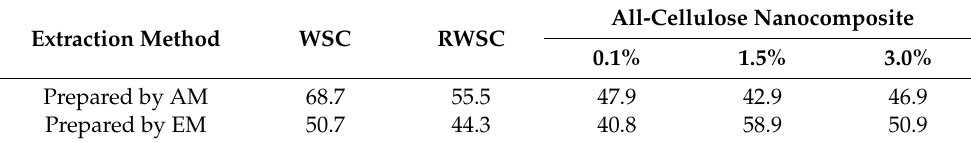
Table 1. Crystallinity index (CrI%) of WSC, RWSC, and all-cellulose nanocomposite. Extraction